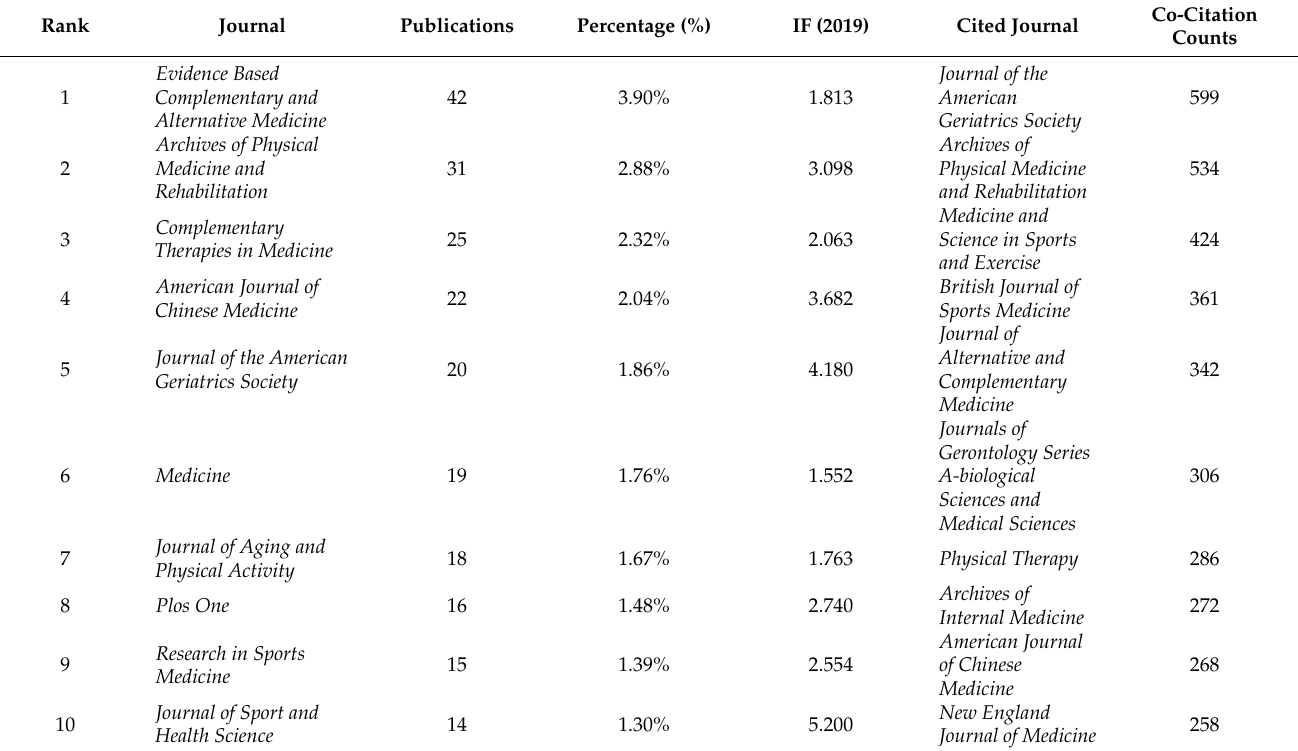
Table 2. Ranking of top 10 journals and co-cited journals in the field of Tai Chi research from 1980 to 2020.